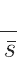
which cannot lead to f 0 or a 0 production in I = 0 , 1 respec- tively. With the topology of Fig. 1 we can obtain the f 0 ( 980